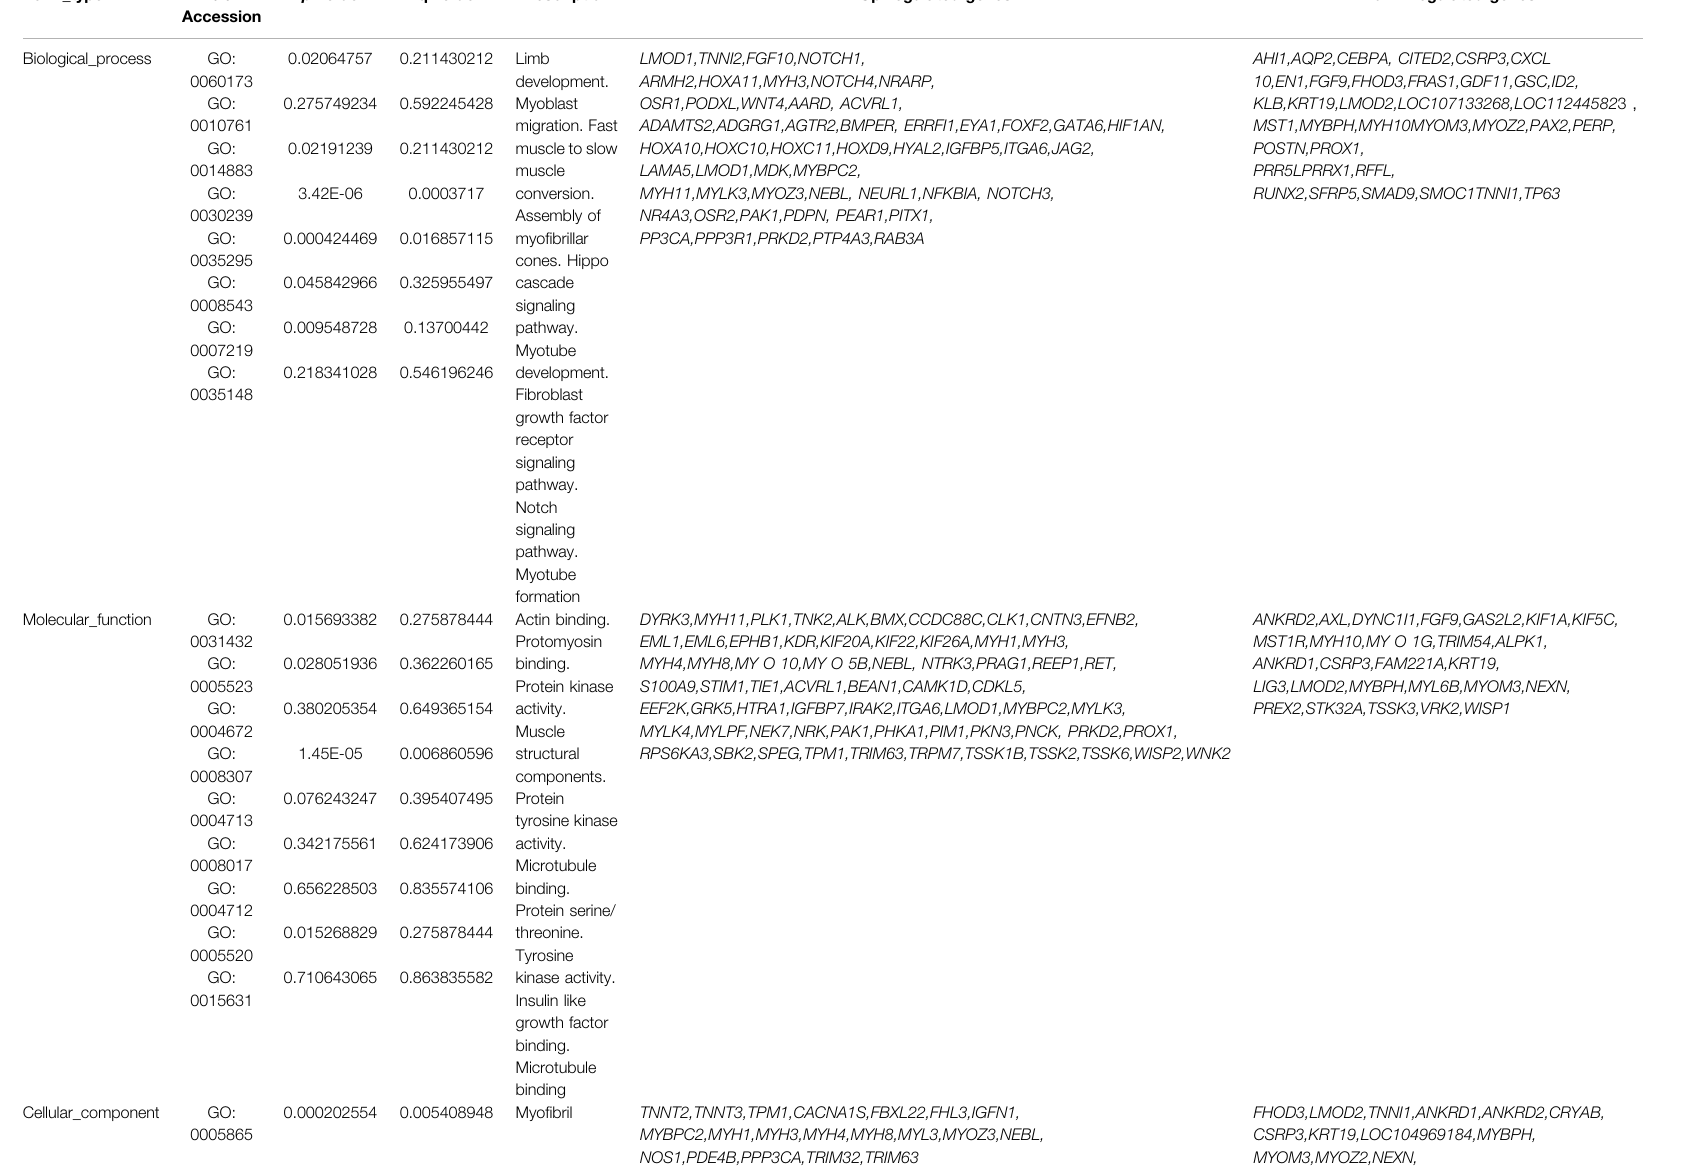
TABLE 2 | Partial GO term related